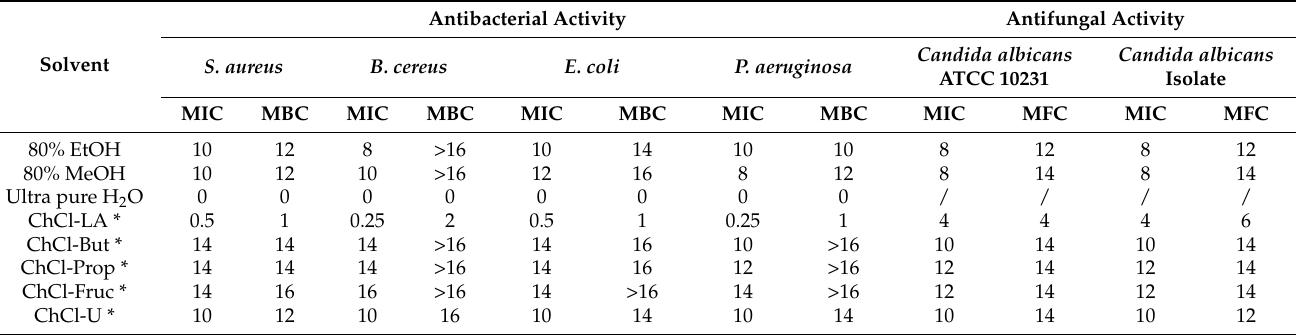
Table 3. Antibacterial (MIC and MBC in % v / v ) and antifungal (MIC and MFC in % v / v ) activity of used solvents.